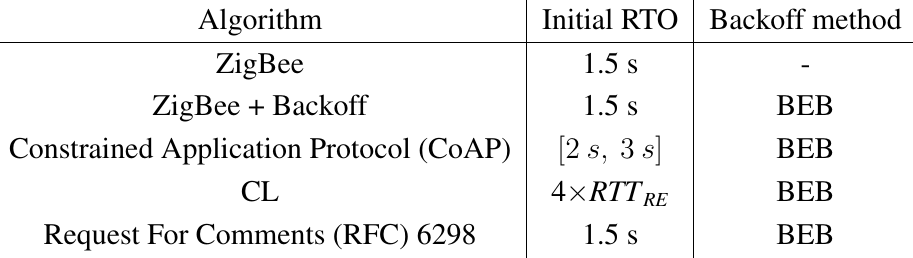
Table 2. The retransmission timeout (RTO) algorithms investigated and their main aspects. BEB, Binary Exponential Backoff; CL, cross layer; RTT, round-trip